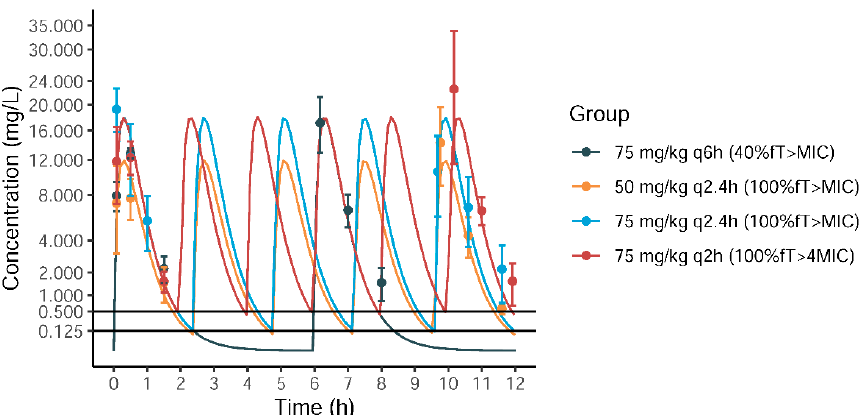
Figure 2. The simulated concentration–time curves and illustrative PD target attainment for different meropenem dosing regimens of 75 mg/kg/q6h (40% f T > MIC), 50 mg/kg/q2.4h (100% f T > MIC), 75 mg/kg/q2.4h (100% f T > MIC), and 75 mg/kg/q2h (100% f T > 4 × MIC) for a treatment duration of 12 h. The dots represent the observed mean ± SD concentrations, and the Y-axis is shown as a square root scale.